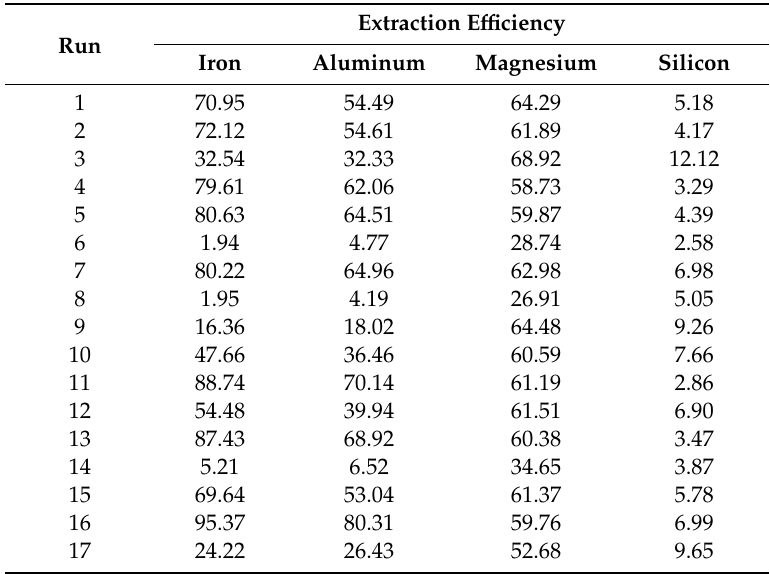
Table 6. Iron, aluminum, magnesium, and silicon extraction e ffi ciencies calculated for each run. Run